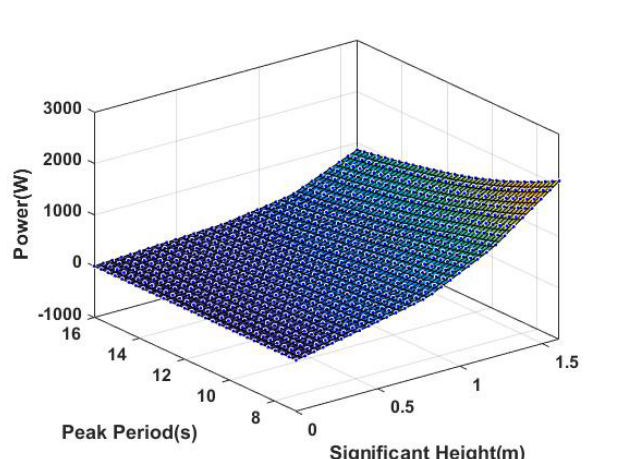
Fig. 16: The fitted power extraction of different waves with a low control limitation.